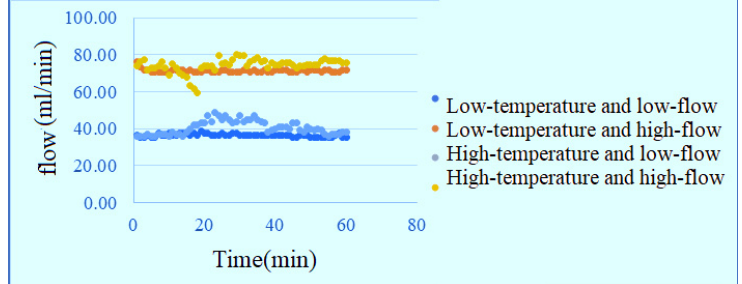
Figure 20. Curve diagram of flow at upper outlet of runner.